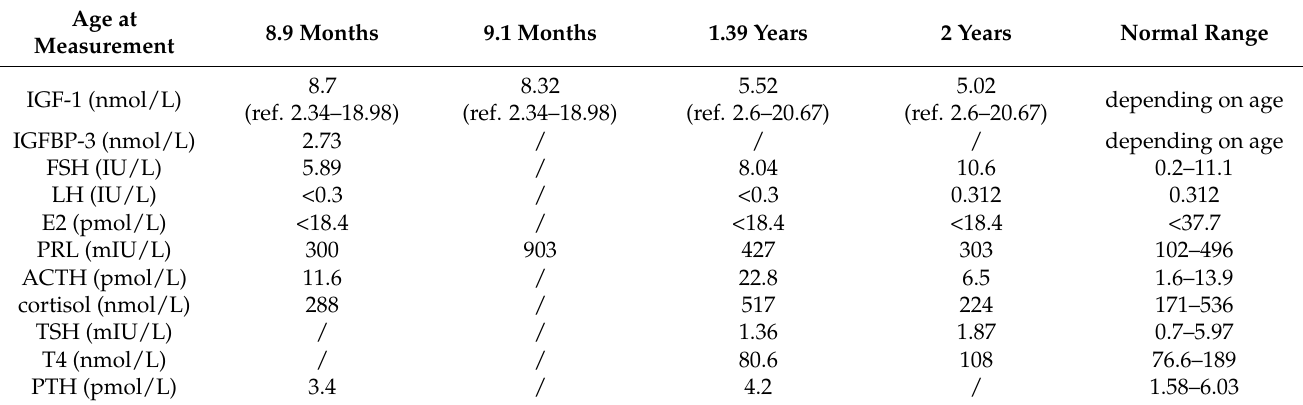
Table 1. Levels of measured hormones at outpatient controls.